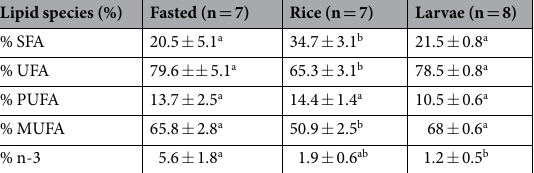
comparison to mass-based instrumentation). TAG composition differed in terms of total SFA, UFA and MUFA among groups, with the Rice group having lower UFA and MUFA, but higher SFA, than the other two groups (Table 3). Furthermore, 1 H NMR spectra of TAG from both Rice and Larvae groups had quantifiable n-3 FA, although significantly lower levels for the Larvae group (Table 3). After 24 hours of the refueling period, we observed significant differences in DNL activity between Rice and Larvae groups, with a significantly higher rate of fractional DNL in the Rice group (30.7 vs. 0.9% day − 1 , respec- tively; p < 0.0001; Fig. 3). This was also accompanied by increased desaturation rates compared to the Larvae group (14.7 vs. 0.2% day − 1 ; p < 0.0001), meaning that nearly half of the newly-synthesized FA were also desat- urated. With regards to glycerol, 2 H-enrichment was also higher in the Rice group with values very similar to those reported for FA of the same group (34.8% day − 1 , Fig. 3). The glycerol 2 H-enrichment in Larvae group was considerably higher relative to the observed FA-enrichments in the same group (6.5% day − 1 , Fig. 3). Enrichment derived from 2 H 2 O in TAG and glycerol of birds in the Fasted group was not detected, as expected in a scenario of null lipogenic activity.